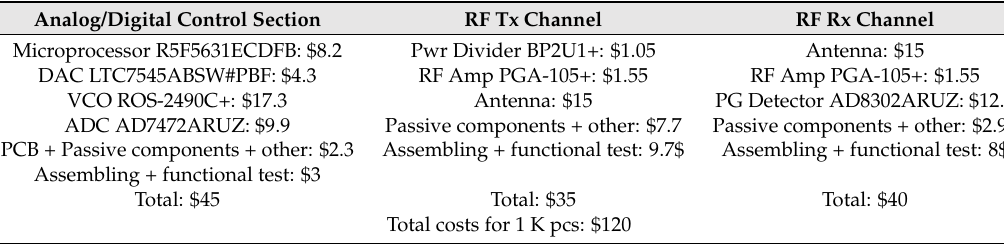
Table 1. Costs of the reader for a production of 1 k